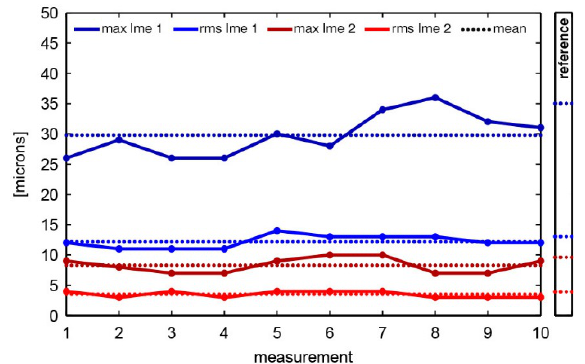
Figure 4. Quality characteristics (typical raw image to JPG conversion)